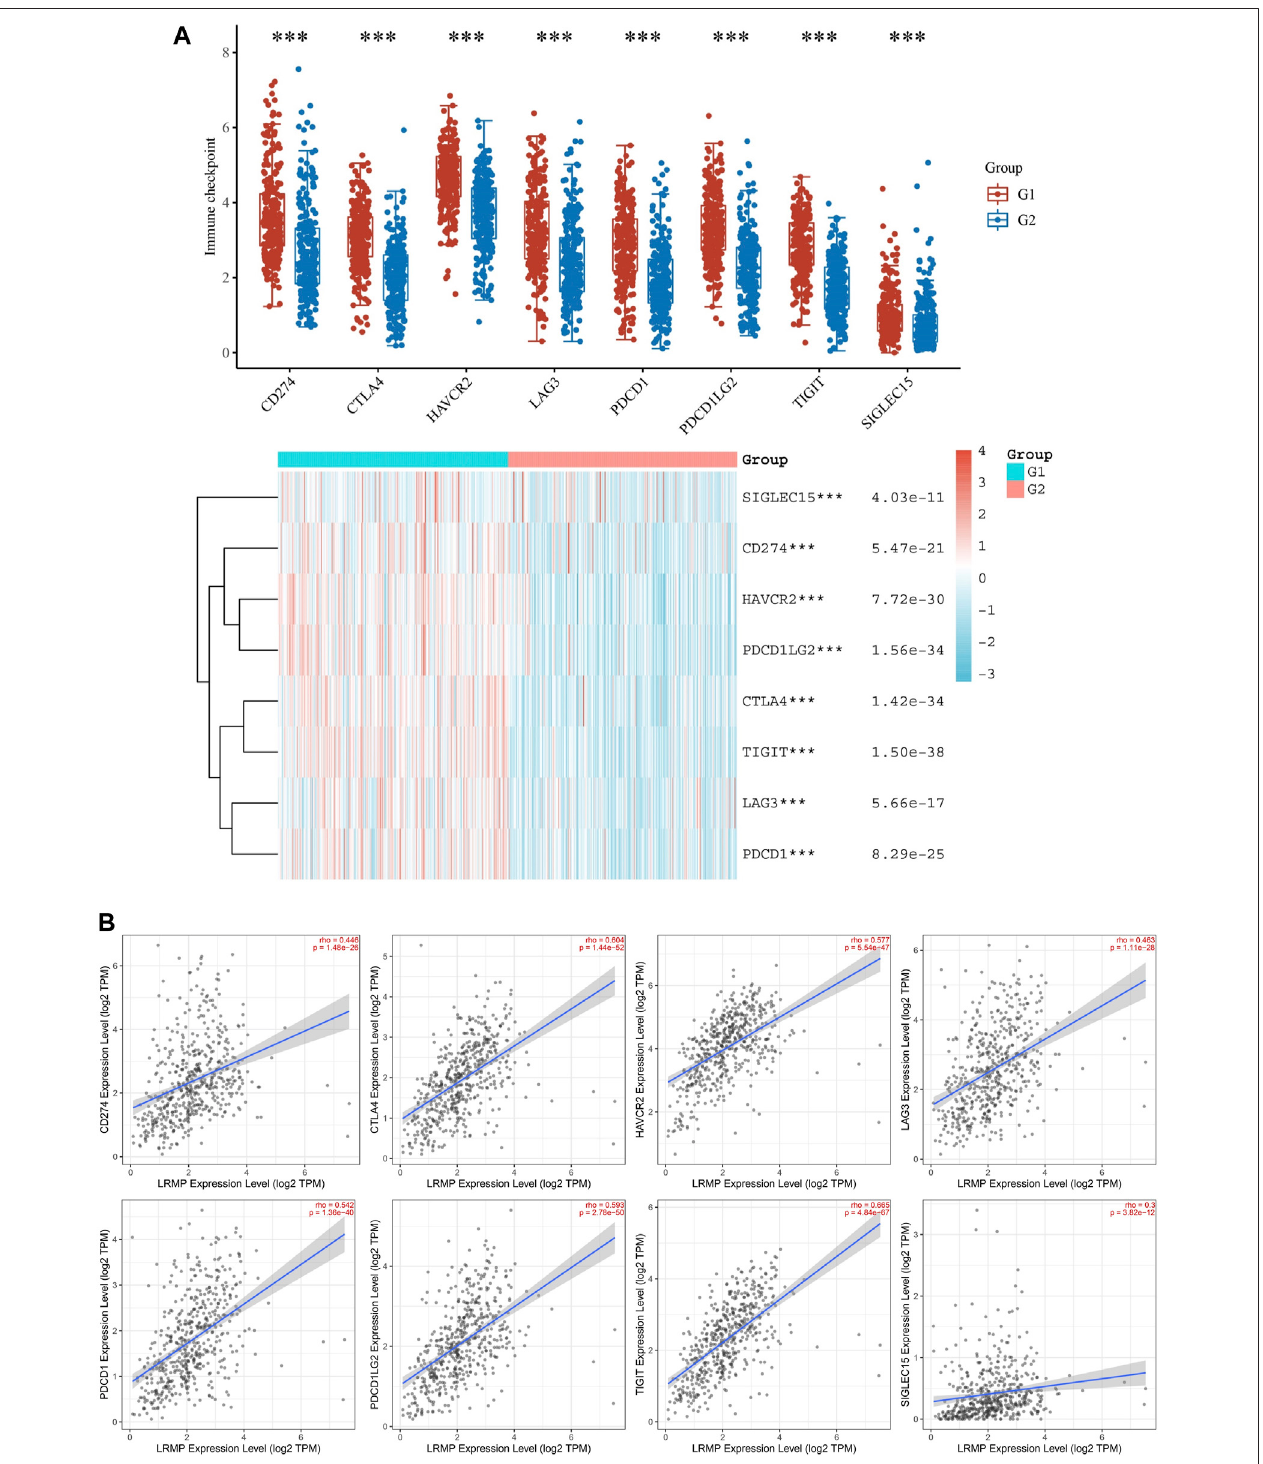
FIGURE9| Correlationoflymphoid-restrictedmembraneprotein( LRMP )expressionwithimmunecheckpointsinlungadenocarcinoma(LUAD). (A) Thedifference in immune checkpoint expression between the two groups divided by LRMP expression (* p < 0.05, ** p < 0.01, *** p < 0.001). (B) The relationship between LRMP and immune checkpoints is demonstrated using a scatter plot in Tumor Immune Estimation Resource (TIMER) 2.0.